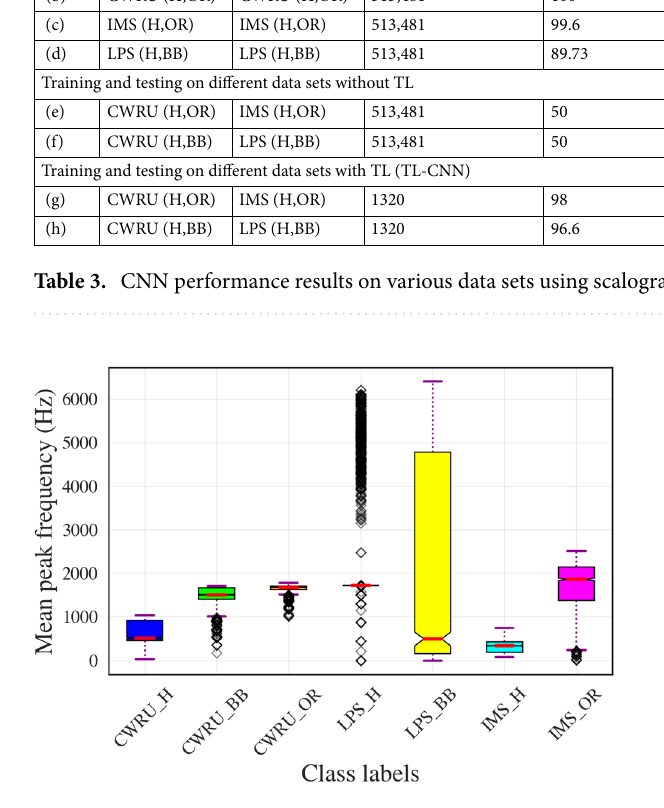
Figure 2. Mean peak frequency (MPF) for vibration data in the three data sets (CWRU, IMS, LPS) corresponding to various operating conditions ( H healthy, BB ball bearing fault, OR outer race